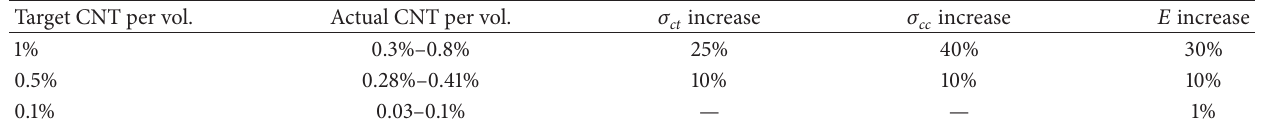
Table 2: Calculated effect of CNT reinforcement in the cementitious matrix. Target CNT per vol. Actual CNT per